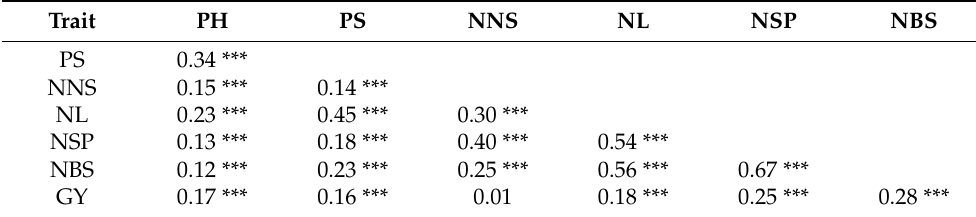
Table 7. Phenotypic correlations between grain yield and yield components at Vaalharts in 2016–2017 and 2017–2018 growing seasons and at Roodeplaat 2016–2017